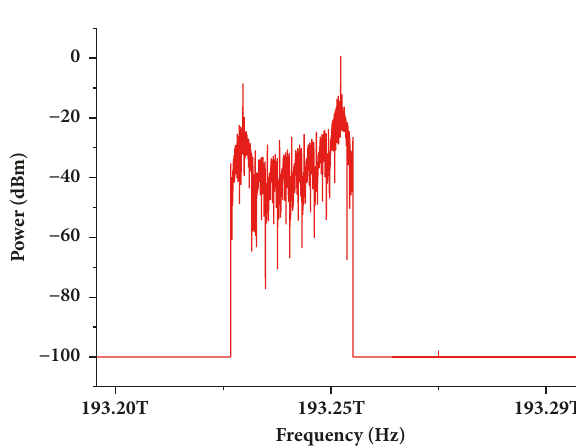
Figure 4: Optical spectrum after OC.